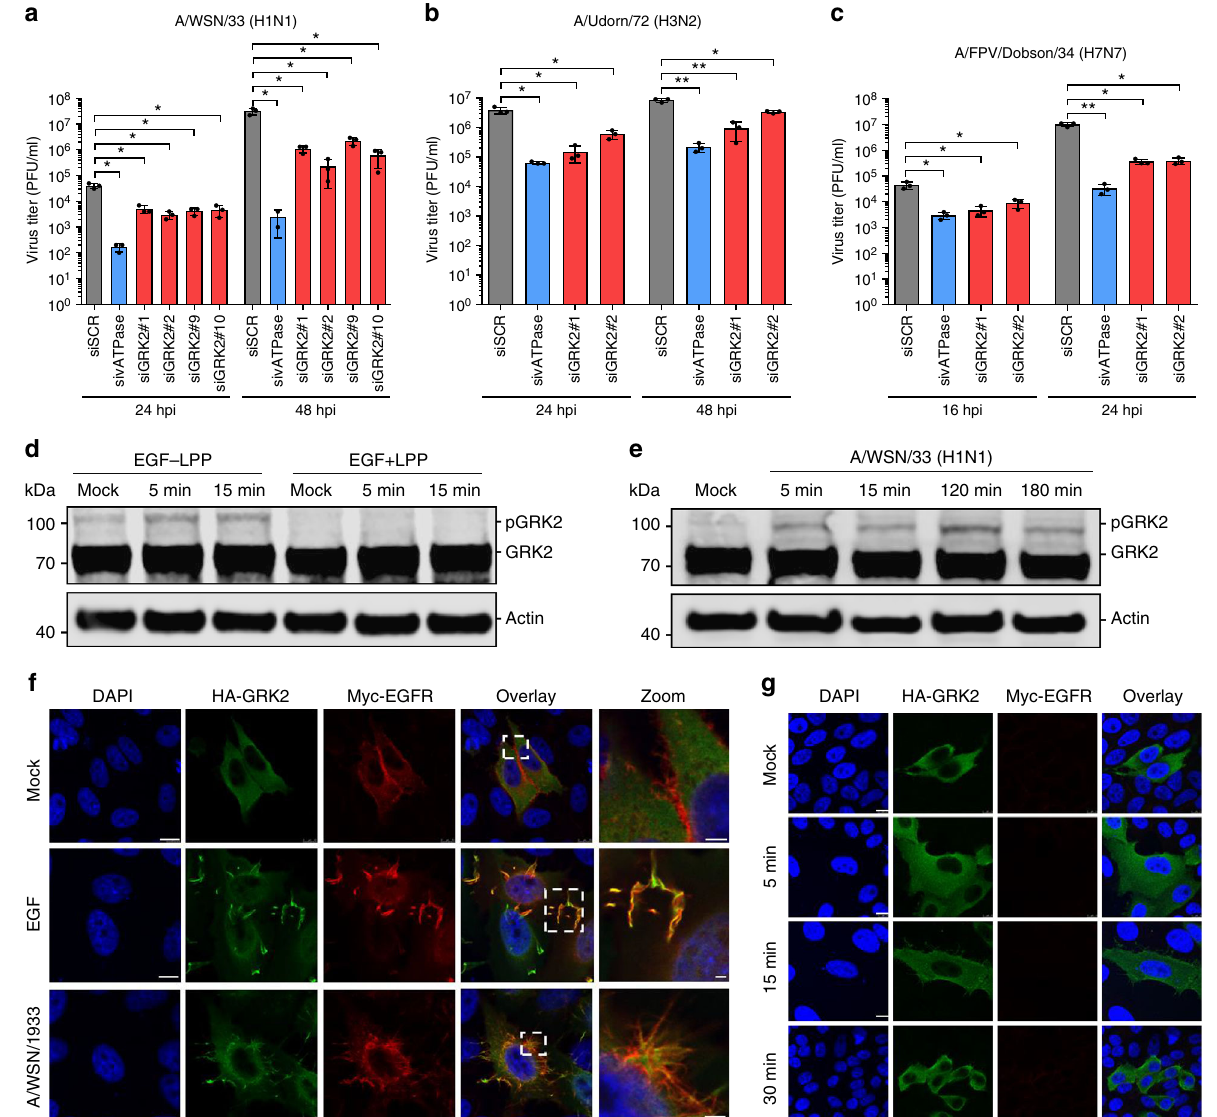
Fig. 3 GRK2 is a proviral host factor that becomes activated within minutes of IAV infection. a – c Effect of GRK2 silencing on the replication of A/WSN/33 (H1N1) ( a ), A/Udorn/72 (H3N2) ( b ) or A/FPV/Dobson/34 (H7N7) ( c ) in A549 cells. At 48 h post siRNA transfection, cells were infected with IAV, supernatants were collected at the indicated times and virus titers were determined by plaque assay. Error bars represent standard deviation from three independent experiments, each performed in triplicates. Statistical signi fi cance was determined by unpaired t -test. For all panels, ns (non-signi fi cant) = P > 0.05; * P ≤ 0.05; ** P ≤ 0.01. d A549 cells were transfected with HA-GRK2 and myc-EGFR-encoding plasmids, serum starved for 16 h before being stimulated with recombinant human epidermal growth factor (hrEGF 100 ng/ml). The phosphorylation status of the indicated proteins was examined using a Zn 2 + Phos-tag gel. Samples on the right ( + LPP) were treated with lambda protein phosphatase (LPP) for 30 min at 30 °C before being run on a Zn 2 + Phos-tag gel. e Same experimental set up as in panel (d), but cells were infected with A/WSN/1933 with an MOI = 100 PFU/cell. f Hep-2 cells were transfected with HA-GRK2- and myc-EGFR-encoding plasmids and 24 h later stimulated with hrEGF or infected with A/WSN/1933 (MOI = 100 PFU/cell) for 15 min. Cells were fi xed and stained using antibodies against the HA-tag (green), EGFR (red) and DAPI (blue) to mark the nuclei. Scale bar corresponds to 10 μ m, for zoom images scale bar corresponds to 2.5 μ m. g Hep-2 cells were transfected with an HA-GRK2-encoding plasmid and 24 h later infected with A/WSN/1933 (MOI = 100 PFU/cell) for 5, 15 or 30 min. Cells were fi xed and stained as in ( f ). Scale bar corresponds to 10 μ